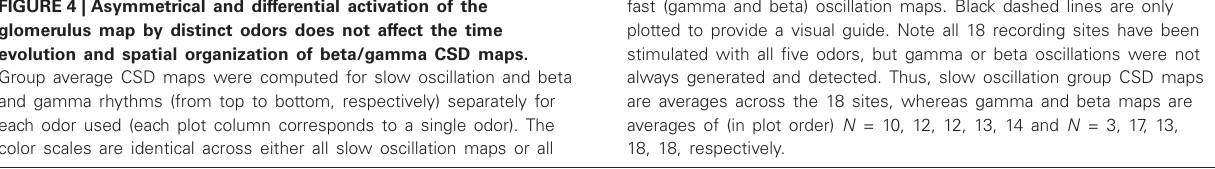
FIGURE 4 | Asymmetrical and differential activation of the glomerulus map by distinct odors does not affect the time evolution and spatial organization of beta/gamma CSD maps. Group average CSD maps were computed for slow oscillation and beta and gamma rhythms (from top to bottom, respectively) separately for each odor used (each plot column corresponds to a single odor). The color scales are identical across either all slow oscillation maps or all